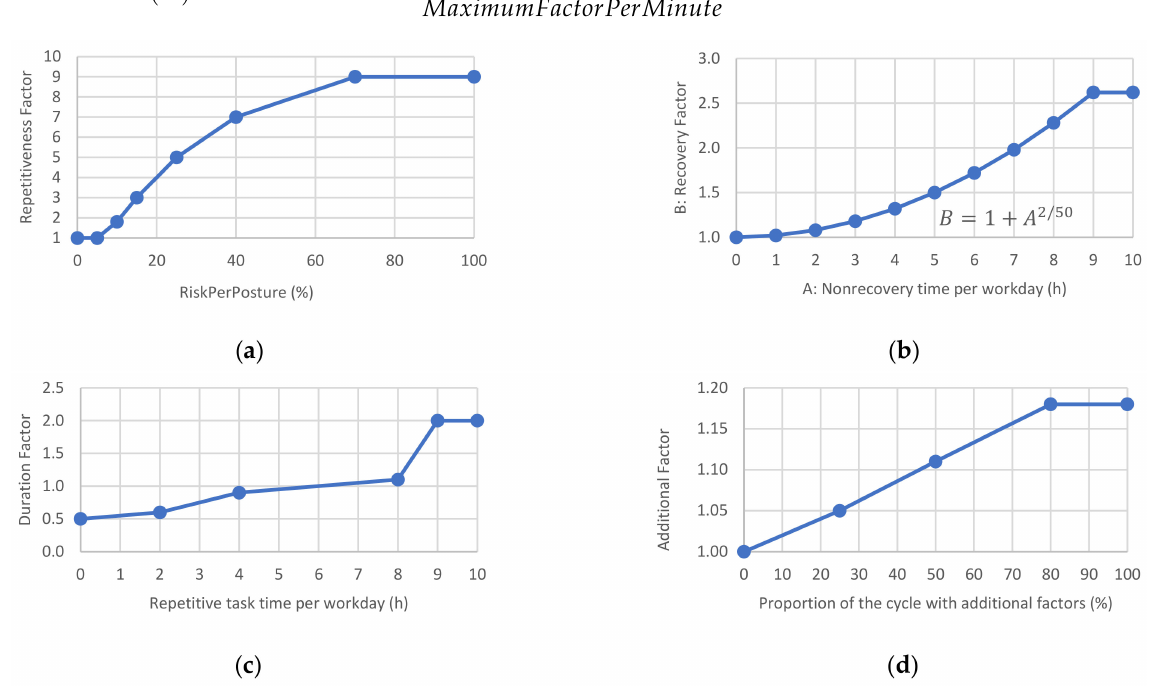
Figure 7. General factor parametric graphs: ( a ) RepetitivenessFactor , ( b ) RecoveryFactor , ( c ) DurationFactor , and ( d ) AdditionalFactor